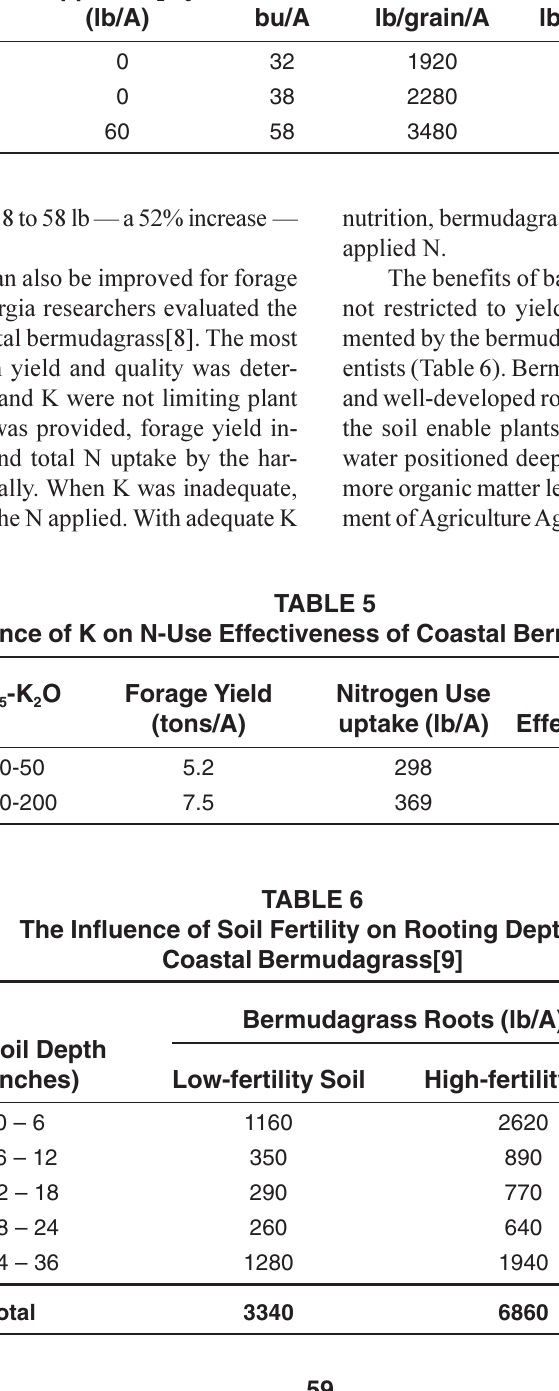
The Effect of P on Dryland Wheat Response to Applied N[7] Wheat Grain Yield